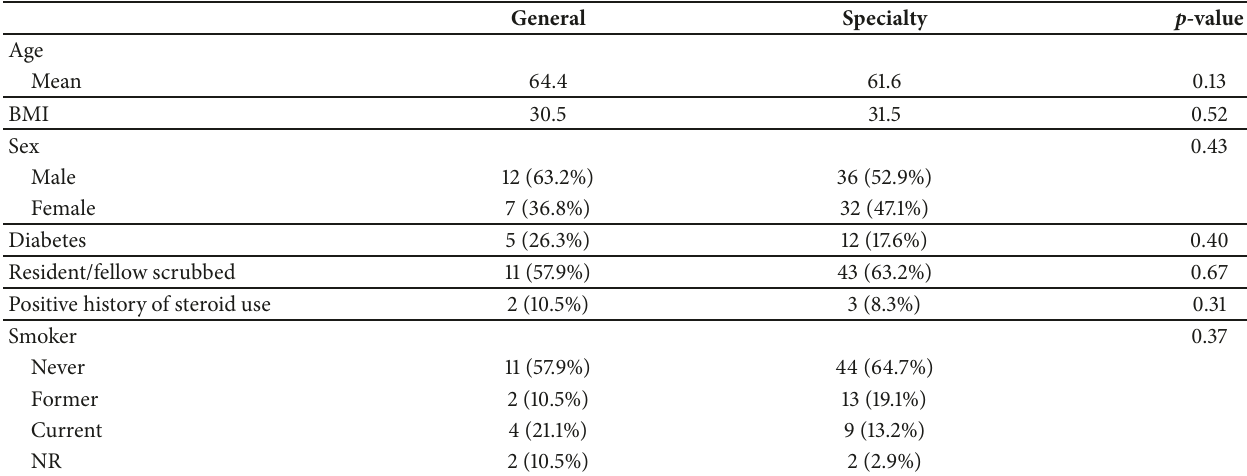
Table 4: Demographic variables at general university versus dedicatedorthopaedic hospital. Demographic variables, such as BMI, sex, diabetes, whether a resident/fellow was scrubbed, positive history of steroid use, and smoking status were examined at the general university versus dedicated orthopaedics specialty hospitals. NR = not reported. For comparisons of age and BMI, Mann–Whitney U nonparametric analysis utilized. For all other variables, X 2 analysis utilized.